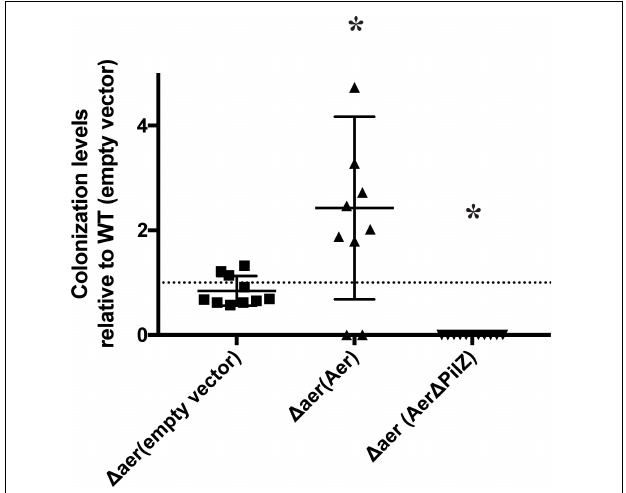
FIGURE 3 | Colonization efficiency of wheat seedling roots by A. brasilense wild type and mutant strains derivative lacking Aer and expressing an empty vector control, Aer or Aer (cid:49) PilZ. The colonization index was the log 10 (strain output/strain input), where the number of CFU extracted from roots after incubation was normalized to the number of CFU measured in the inoculated input. The dotted line value at 1 indicates the colonization index of the WT(empty vector). Points above the line are representative of a higher colonization efficiency, while points below the line are indicative of a lower colonization efficiency. ∗ indicates significant difference from WT(empty vector) ( p -value <